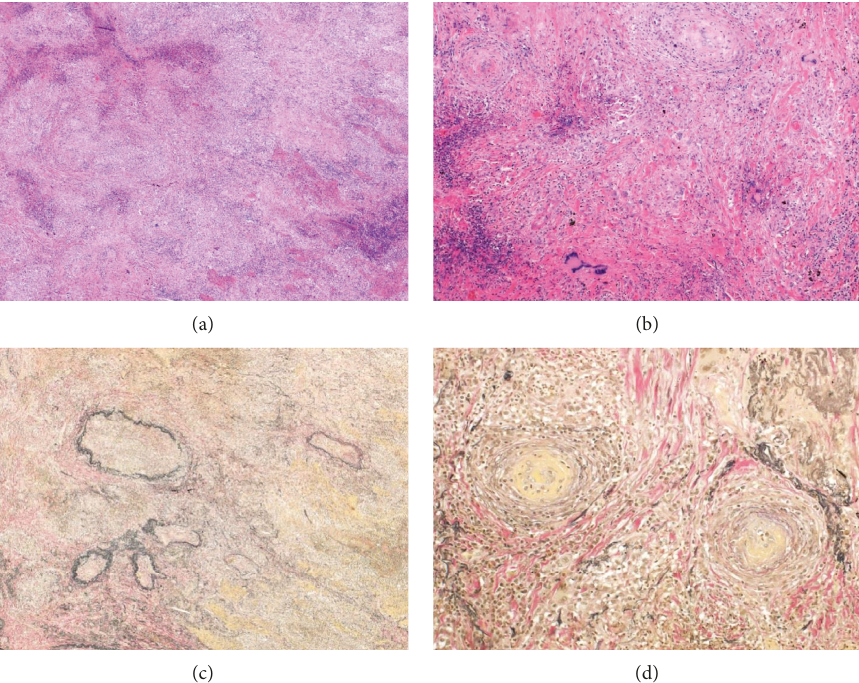
Figure 2: Histopathological findings of lung nodules from our patient with granulomatosis with polyangiitis. (a) Hematoxylin and eosin (H&E) staining ( × 40) of lung biopsy showing necrosis and inflammatory cell infiltration. (b) H&E staining ( × 100) of lung biopsy showing vascular occlusion and multinucleated giant cells. (c) Elastica van Gieson (EVG) staining ( × 40) of the lung showing destruction of the arterial medium. (d) EVG staining ( × 100) of lung biopsy showing vascular